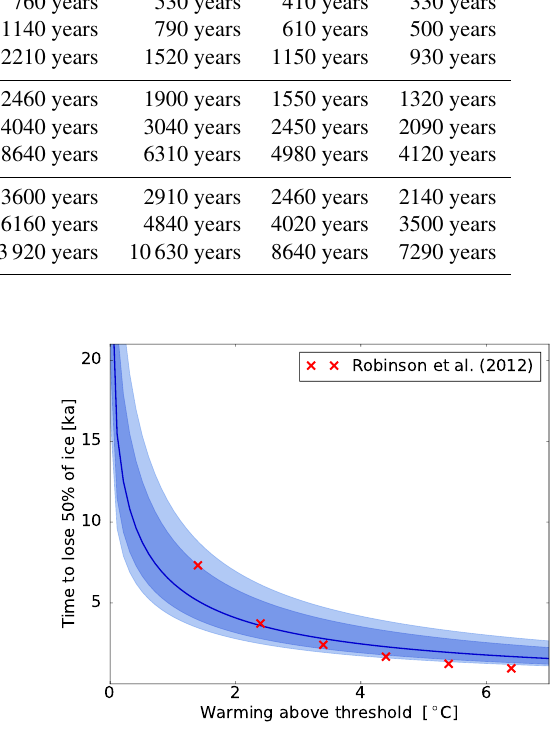
Figure 3. Time until 50% of the Greenland Ice Sheet is melted. Shown are the median (black line) and the likely (18–83% per- centiles, dark blue shading) and very likely (5–95% percentiles, light blue shading) ranges for the time to melt 50% of the present- day ice volume, estimated via the equation for the decay time τ α . The red crosses indicate the results from process-based model sim- ulations by Robinson et al.